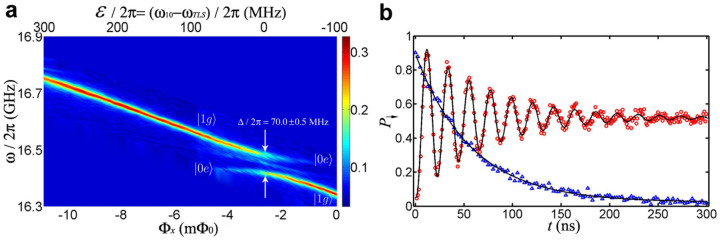
Spectroscopy and Rabi oscillation.(a) Microwave spectroscopy measurement of the coupled qubit-TLS system. The splitting is Δ/2π = 70.0 ± 0.5 MHz centered at ω/2π = 16.450 ± 0.002 GHz. The beginning point of the flux bias for the single passage LZ sweeping is denoted as 0 mΦ0, corresponding to εi/2π = (ω10 − ωTLS)/2π ≈ −100 MHz in the upper abscissa. (b) Rabi oscillation and T1 at εi, respectively. The experimental data (the red circles and blue triangles) agree well with the theoretical fits (the black solid lines).